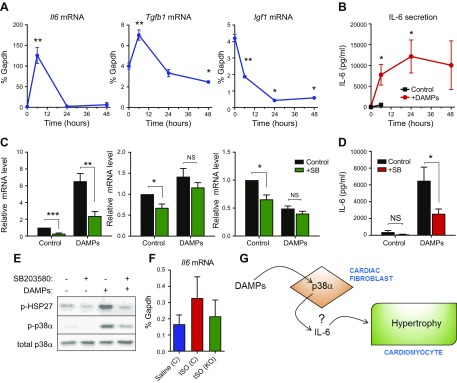
Role of p38α in DAMPs-modulated expression of hypertrophy-inducing genes in cardiac fibroblasts. A) Real-time RT-PCR showing time of effect of DAMPs on mRNA expression of Il6, Tgfb1, and Igf1. *P < 0.05, **P < 0.01 (n = 3). B) ELISA showing time of IL-6 secretion from cardiac fibroblasts stimulated with cardiac DAMPs. Red filled circles represent DAMP-stimulated IL-6 secretion, and black-filled squares represent basal secretion without addition of DAMPs (measured up to 6 h only). *P < 0.05 compared with time 0 (n = 3). C) Real-time RT-PCR data showing effect of 10 μM SB203580 or DMSO vehicle control on DAMP-induced expression of hypertrophy-inducing genes after 6 h (n = 9). *P < 0.05, **P < 0.01, ***P < 0.001 (ANOVA with Šidák post hoc test). NS, not significant. Data normalized to Gapdh mRNA levels and expressed relative to the control. D) ELISA showing effect of 10 μM SB203580 or DMSO vehicle control on DAMP-induced IL-6 secretion after 6 h (n = 9). ANOVA with Sĭdák post hoc test. *P < 0.05; NS, not significant. E) Western blot showing DAMP-induced phosphorylation (p-) of HSP27 and p38α after 20 min and inhibition by 10 μM SB203580. Total p38α expression was included as the loading control. Blots are representative of 3 separate experiments. F) Control or Fb-p38α KO mice were injected with tamoxifen, and miniosmotic pumps were implanted for delivery of saline or ISO as in Fig. 2A. Pumps were removed, and heart tissue was collected 1 wk later. Bar chart shows real-time RT-PCR analysis of cardiac Il6 mRNA levels (means ± sem). Group sizes: control saline (n = 11), control ISO (n = 9), and KO ISO (n = 11). ANOVA with Sĭdák post hoc test: not significant. G) Schematic depicting role of fibroblast p38α in modulating cardiomyocyte hypertrophy.